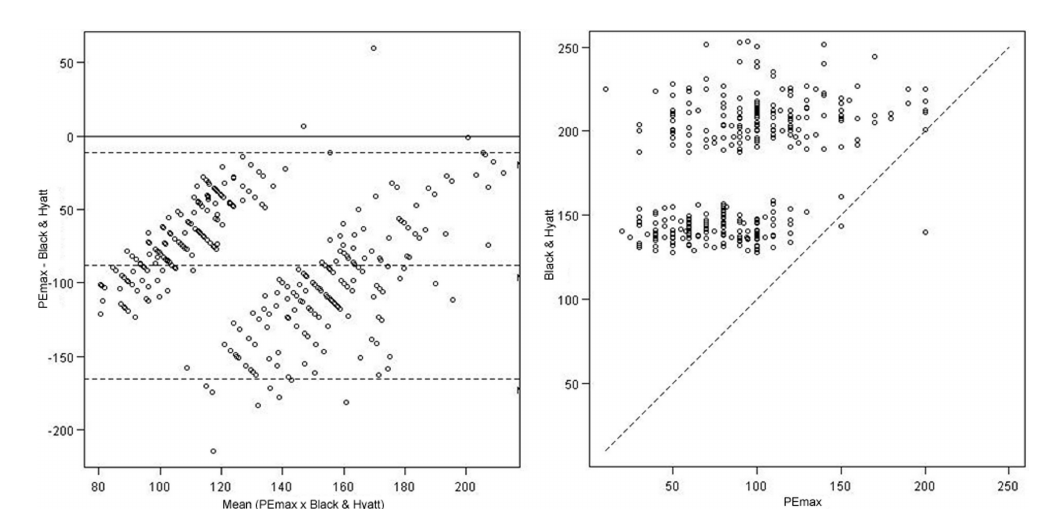
Fig. 4 - Bland-Altman plot and Lin's concordance coefficient of maximal expiratory pressure (MEP) values predicted by the formula of Black and Hyatt. Confidence interval 95% (0.08 – 0.13); Lin coefficient